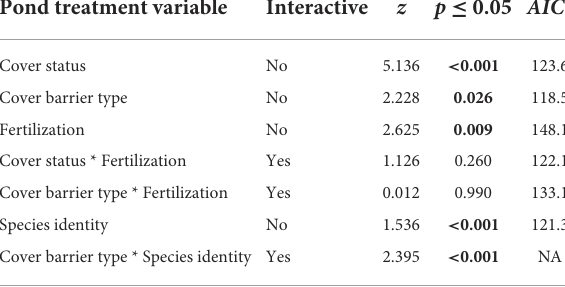
TABLE 2 Results of logistic regression models for separate and interactive influences of various pond treatment effects on the success of deterring birds against predation on pond